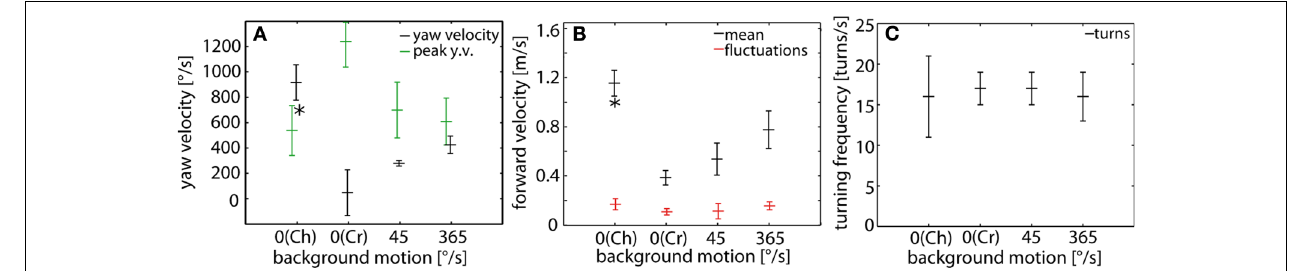
FIGURE 3 | (A) Yaw velocity, (B) turning frequency and (C) forward velocity during chases ( Ch ; stationary background), cruising fl ights ( Cr ; stationary background) and optomotor following induced by a slowly ( 45 ° /s) and fast ( 365 ° /s) moving background. Data obtained from chasing fl ights represent the averages over C- and P-chases. (A) Time averaged yaw velocities ( ± SD) of a sample of fl ies ( black ) and mean peak yaw velocity deviations of the yaw velocity from its respective mean value ( ± SD) of the same sample of fl ies ( green ). The fl ies’ mean yaw velocity is near 900 ° /s for males pursuing a target that moved at 700 ° /s ( asterisk ). In cruising fl ights, the mean yaw velocity is close to 0 ° /s. In optomotor fl ights the fl y’s mean yaw velocity increases with